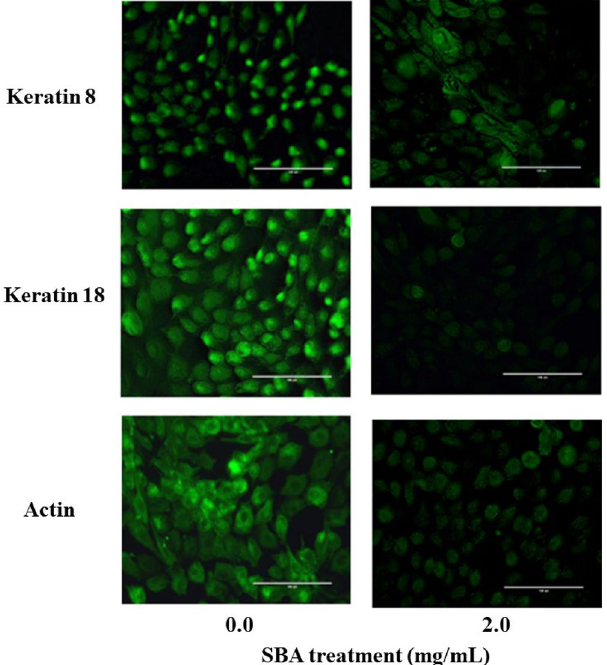
Figure 4. Differential characteristics of KRT8, KRT18 and ACTA expressions observed by confocal microscopy in IPEC-J2. IPEC-J2s were grown on glass slides within 6-well plates until reaching complete confluence and were then treated with 0 or 2.0 mg/mL SBA for 24 h. Representative images of KRT8, KRT18 and ACTA in different SBA treatments were captured at a magnification of 200 × .